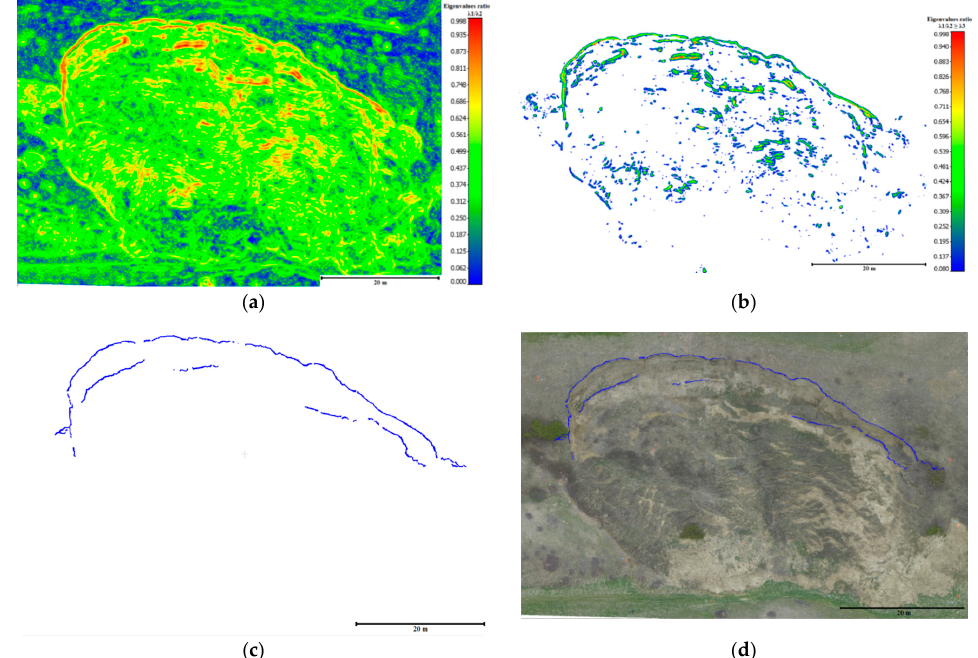
Figure 14. Extracted landslide scarps using eigenvalue ratio ( λ 1 / λ 2 ≥ λ 3 ) computed using the dense 3D image-based point cloud dataset collected in May 2014 for the study landslide, Lethbridge, Alberta. ( a ) Eigenvalue ratio ( λ 1/ λ 2); ( b ) extraction of landslide scarp features based on variation in the local topography’s eigenvalue ratio; ( c ) final landslide scarp detection results based on eigenvalues ratios of the topographic surface index; (d) scarps overlaid on the orthophoto using UAV images of the study area.